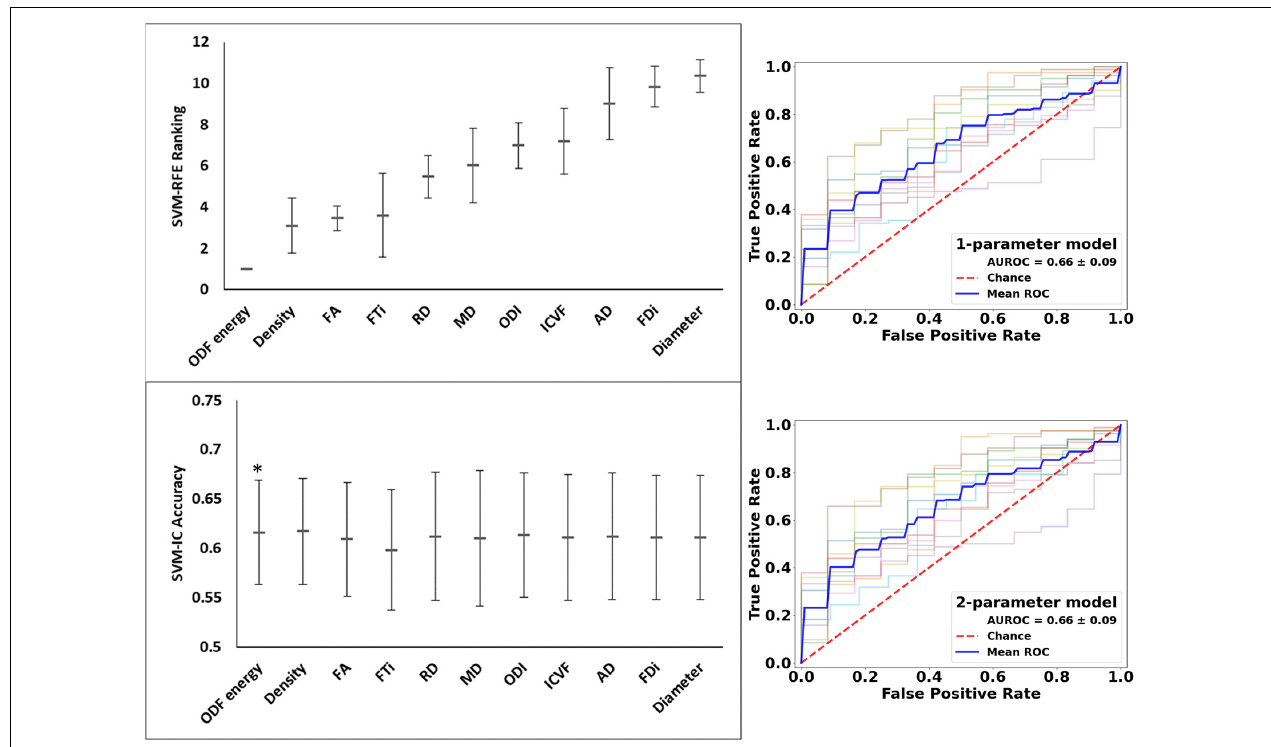
FIGURE 10 | Feature ranks and performance comparison in the classification of NAWM tissue between high and low disease patients. Top Left Panel: The mean (standard deviation) rankings of the 11 diffusion features used in this analysis based on the linear recursive feature elimination (RFE) algorithm in SVM. Bottom Left Panel: Accuracy of the classification models (SVM-IC) achieved by adding features one at a time, starting from the highest to the lowest rankings. Right Panel: ROC curves for models constructed using the top two ranked diffusion features: [top orientation distribution function (ODF) energy alone, and bottom] ODF energy + Density (AD). ROC, receiver operating characteristics; AUROC, area under the ROC curve (* p <